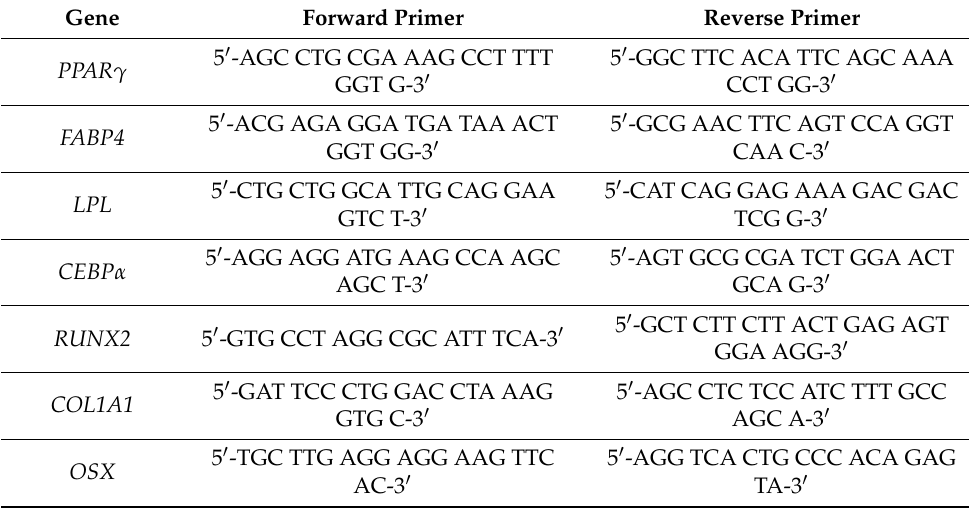
Table 1. List of